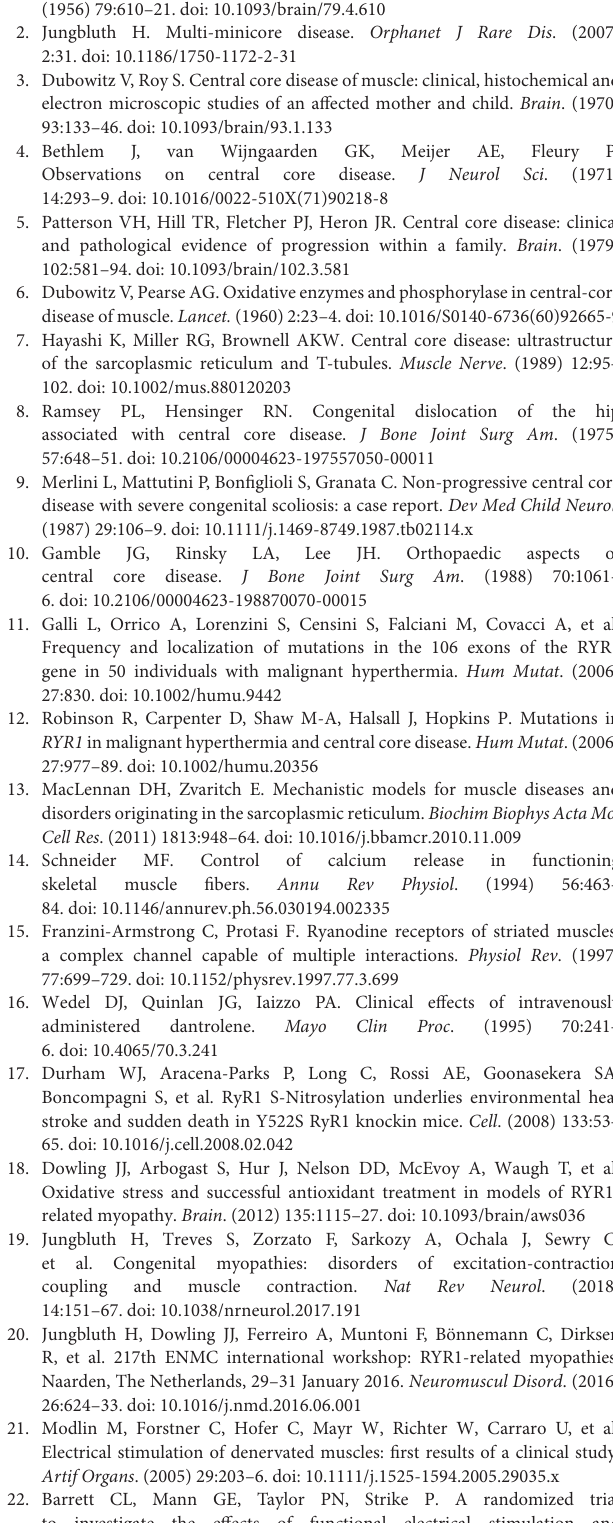
A method for the ultrastructural preservation of tiny percutaneous needle